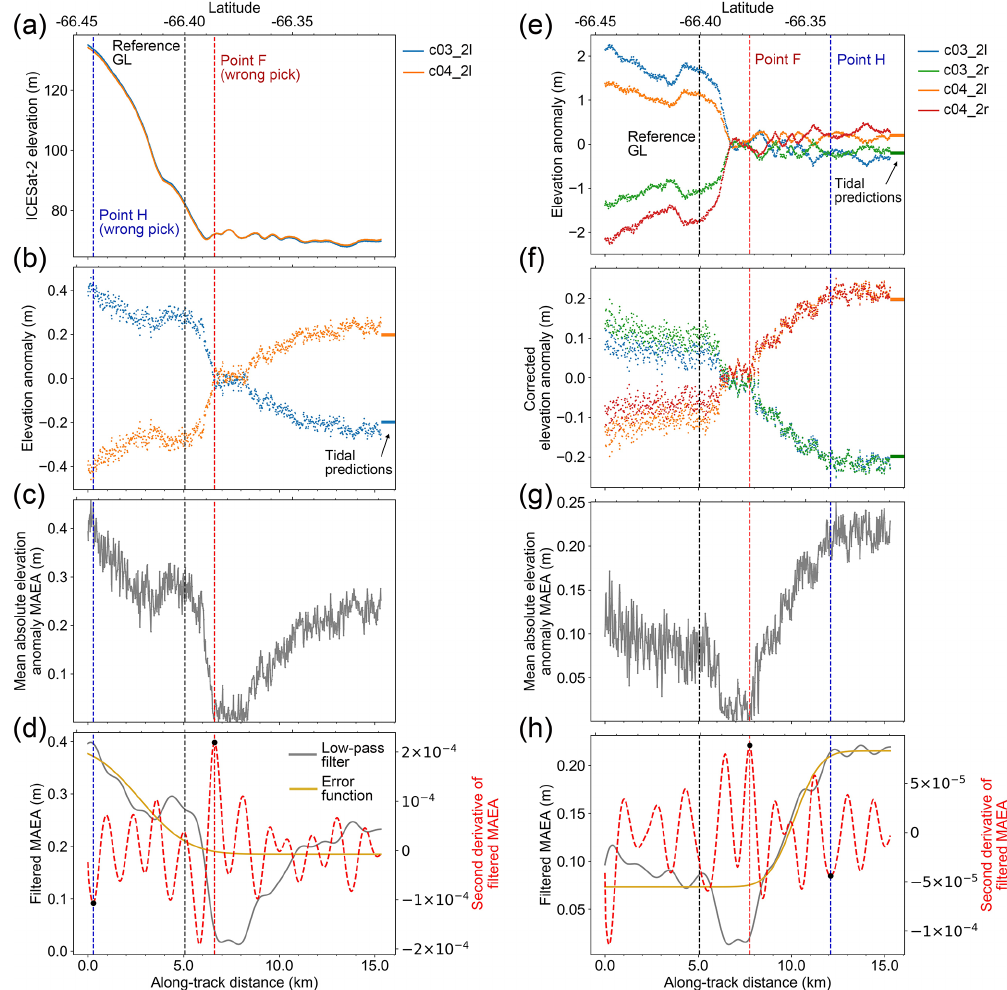
Figure 6. Comparison between repeat-track analysis for single beams and beam pairs. (a–d) ICESat-2 repeat-track analysis for two left beams from repeat cycles 3 and 4 in beam pair 2 of track 506. The location of track 506 beam pair 2 is shown in Fig. 2. Same as Fig. 5, but showing the wrong grounding zone (GZ) features picked by repeat-track analysis due to large across-track slope on land ice. (e, f) ICESat-2 repeat-track analysis for both left and right beams in beam pair 2 of track 506 from repeat cycles 3 and 4. (e) The elevation anomalies of each track. (f) The corrected elevation anomalies after across-track slope correction. (g, h) Same as Fig. 5c and